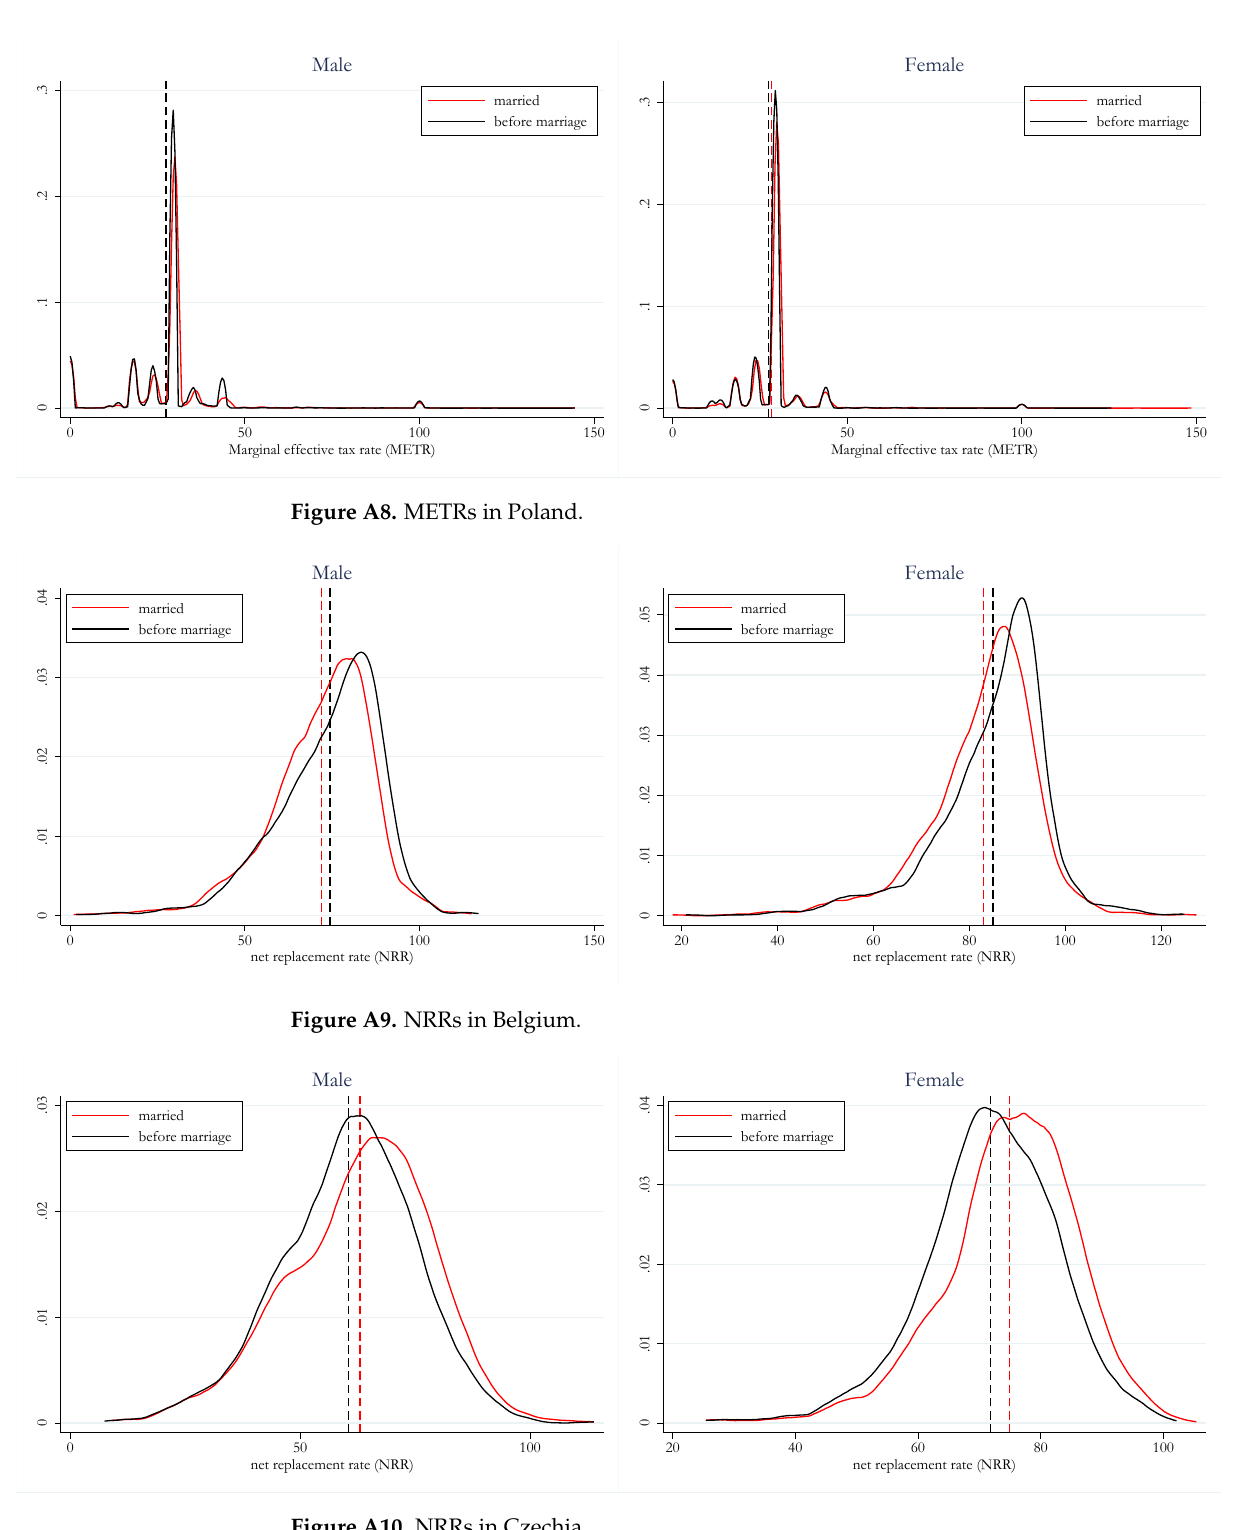
Figure A10. NRRs in